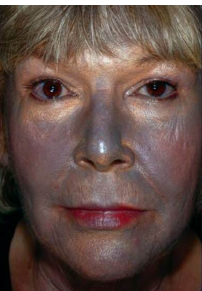
Figure 5. Typical skin pigmentation due to argyria. Photograph obtained from [29].